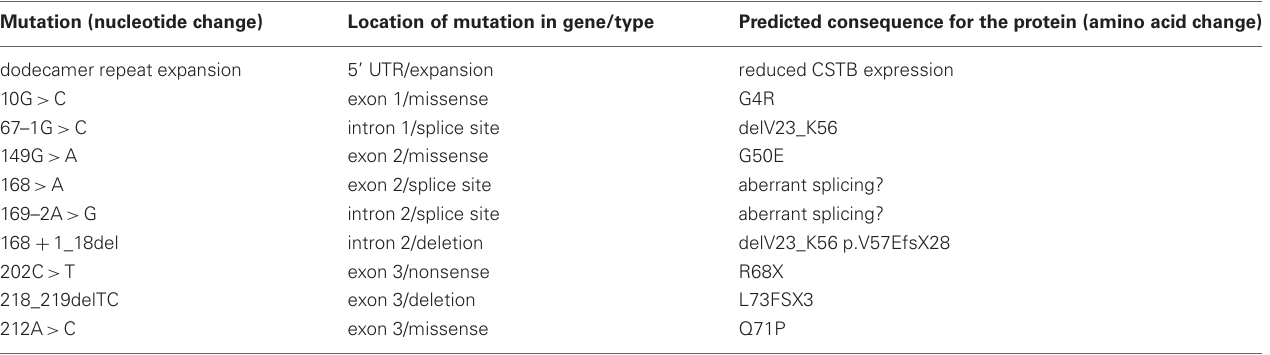
Table 1 | Mutations in CSTB underlying Unverricht-Lundborg disease (EPM1) (Joensuu et al., 2008). Mutation (nucleotide change) Location of mutation in gene/type Predicted consequence for the protein (amino acid